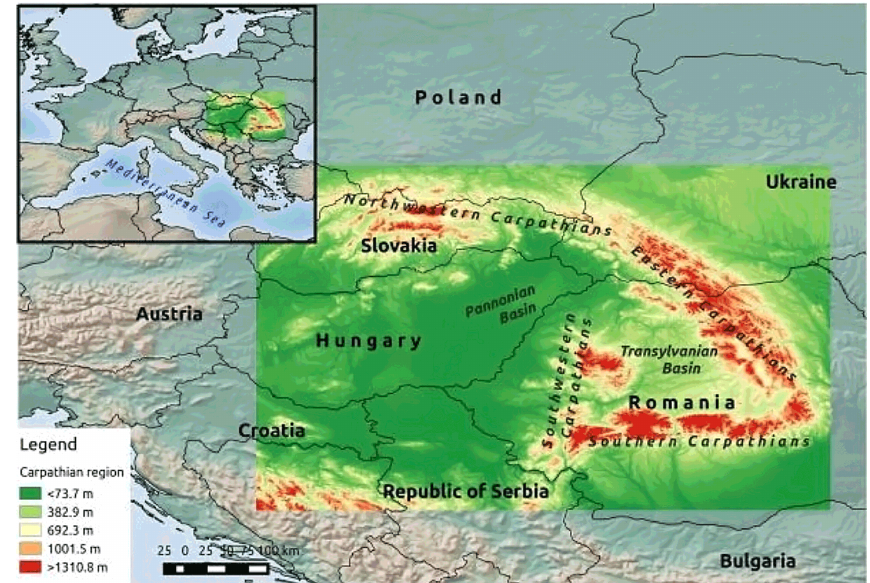
Figure 1. Carpathian region – geographical